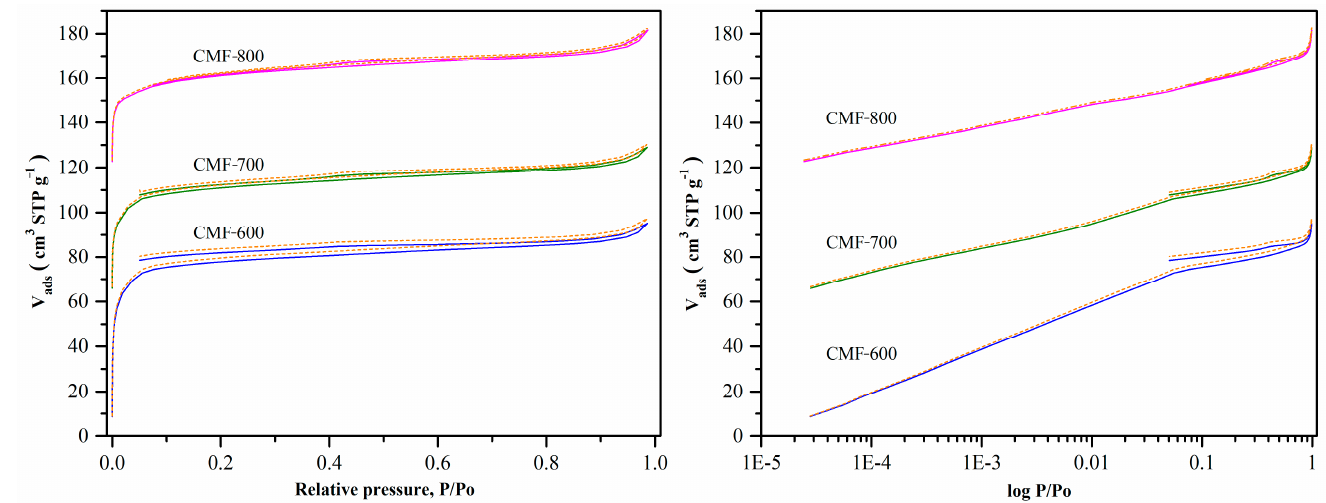
Figure 5. Nitrogen isotherms for carbon materials at − 196.15 with equilibration time of 10 min and tolerance 0 (solid line) and 9 (dotted line). Nitrogen adsorption isotherms in linear (left) and logarithmic (right) scale.